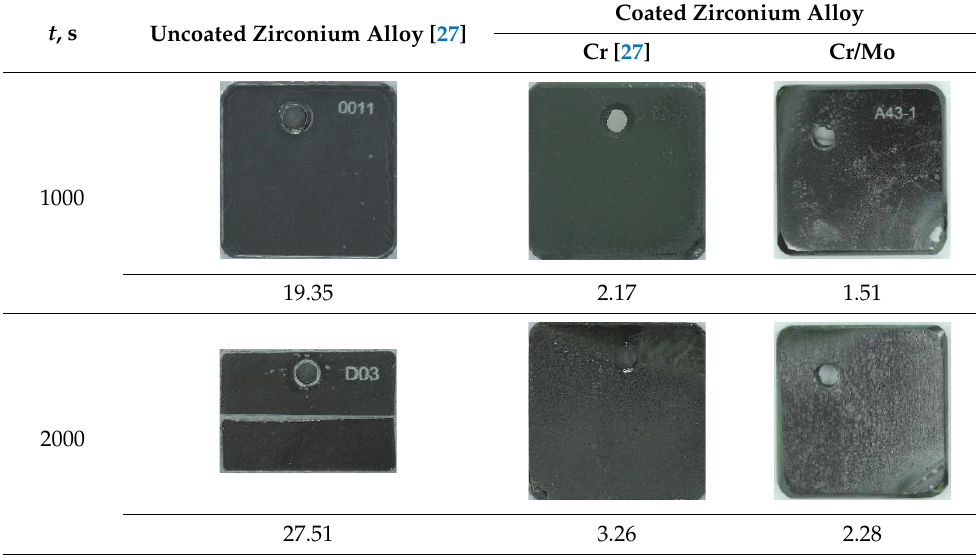
Table 2. The outer view and weight gain (in mg/cm 2 ) of the samples after LOCA oxidation at 1200 °C. t , s